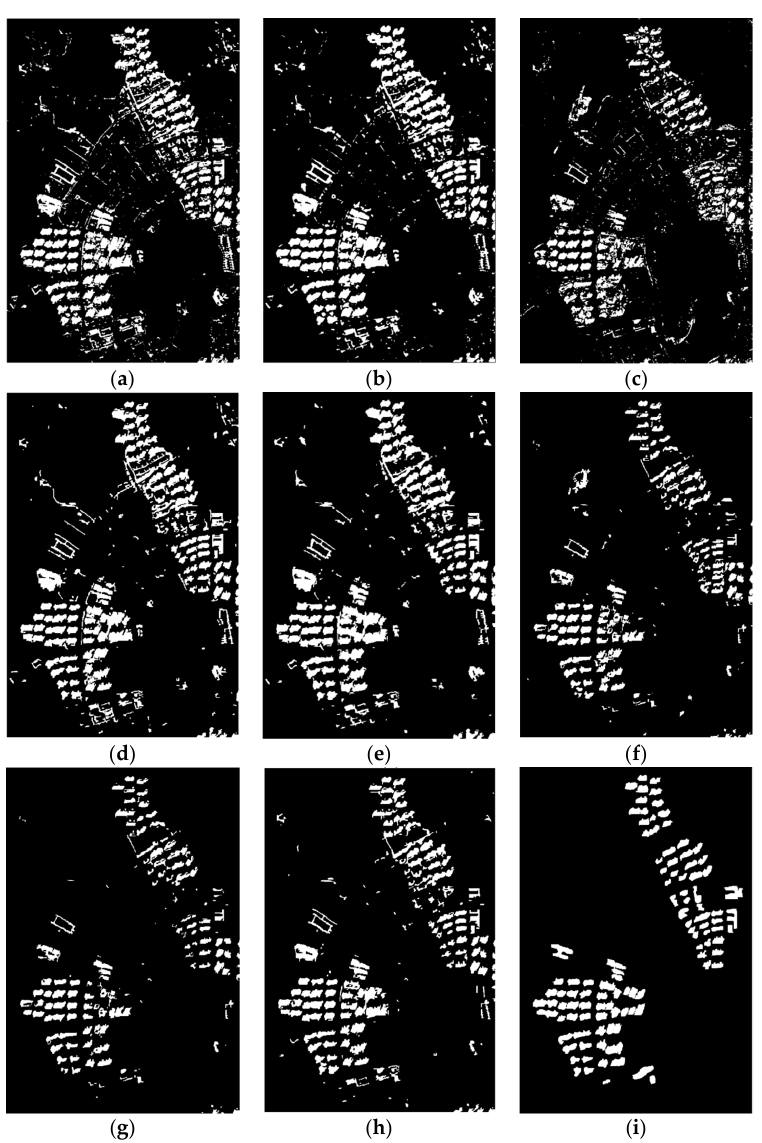
Figure 7. Change detection results of the second subset: ( a ) PBCD using CVA, ( b ) PBCD using PCA, ( c ) PBCD using IRMAD, ( d ) OBCD using CVA, ( e ) OBCD using PCA, ( f ) OBCD using IRMAD, ( g ) OBCD using major voting, ( h ) OBCD using the proposed method, and ( i ) the reference map.